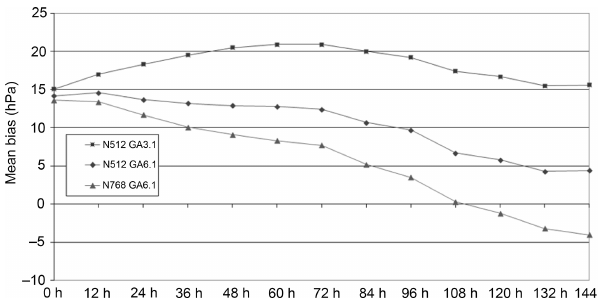
Figure 11. Mean tropical cyclone central pressure bias during data assimilation trials run from June to September 2012. Reproduced from Heming (2016), but with altered labels in the legend.